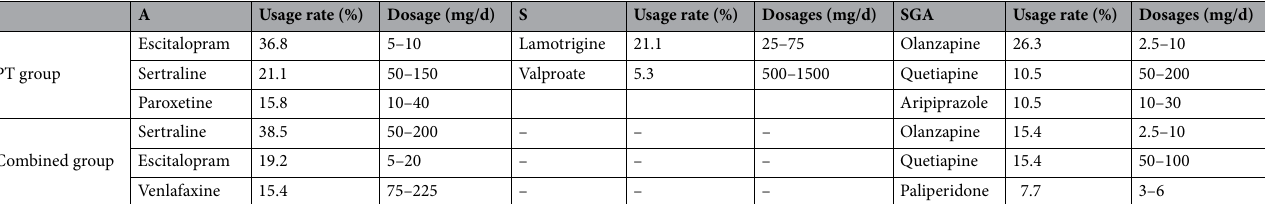
Table 4. The drug use and dosages in different groups.